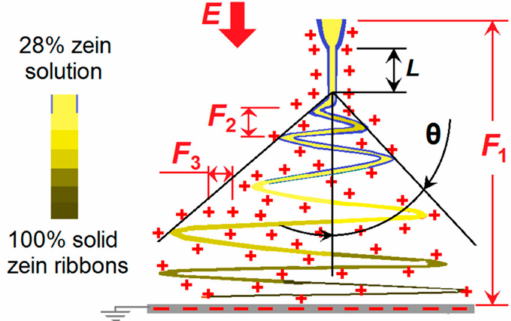
Figure 9. A diagram showing the formation mechanism of electrospun nanoribbons through the modified coaxial